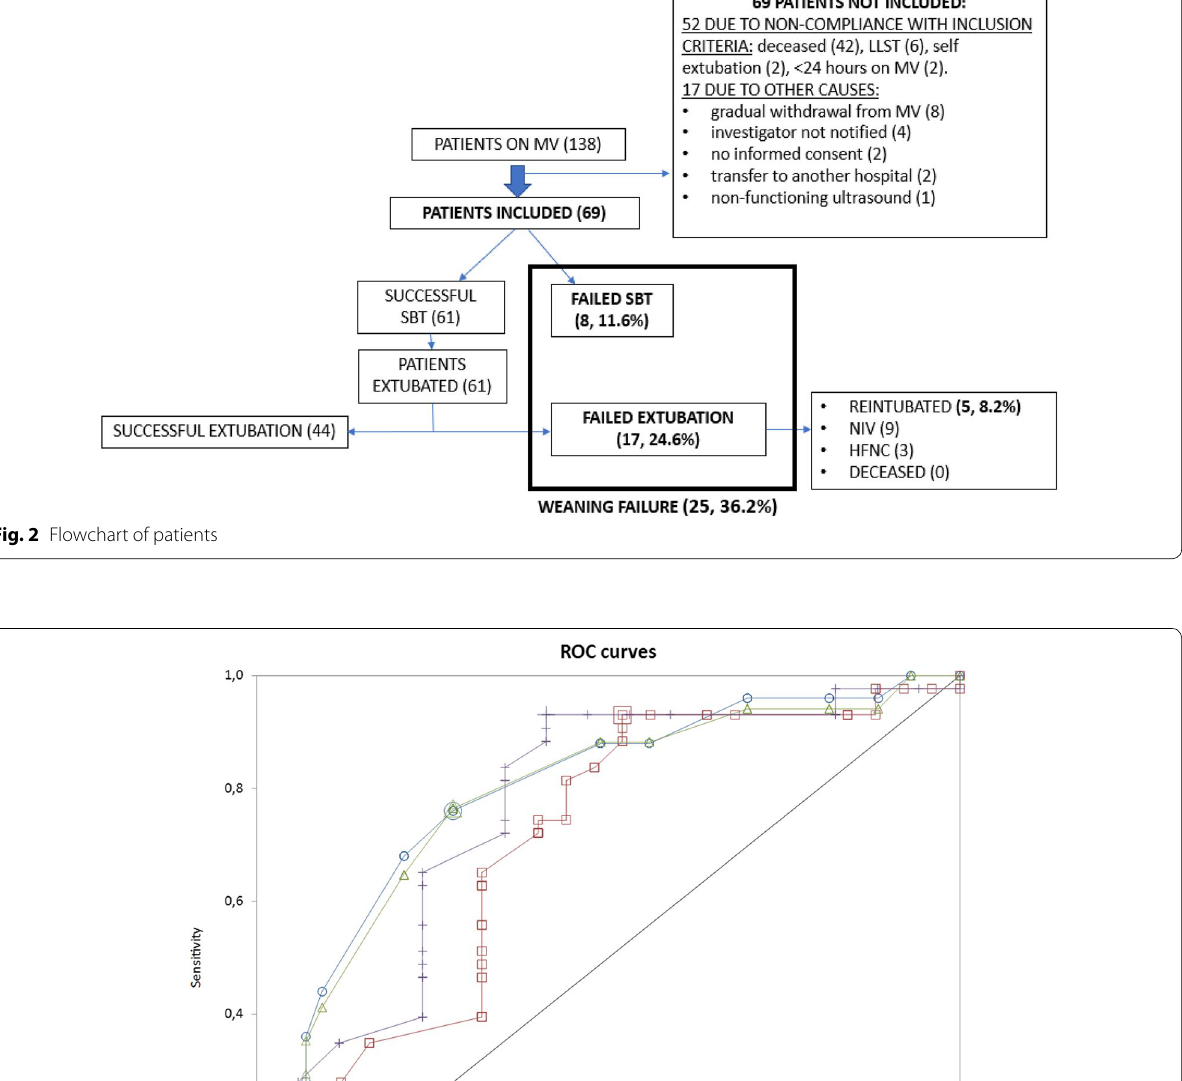
), in successful extubation (SE) (White square) and LUSm in SW (White +